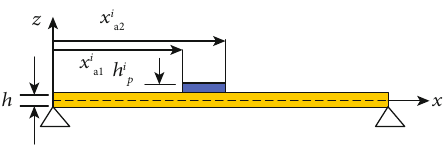
Figure 1: Beam under a PZT